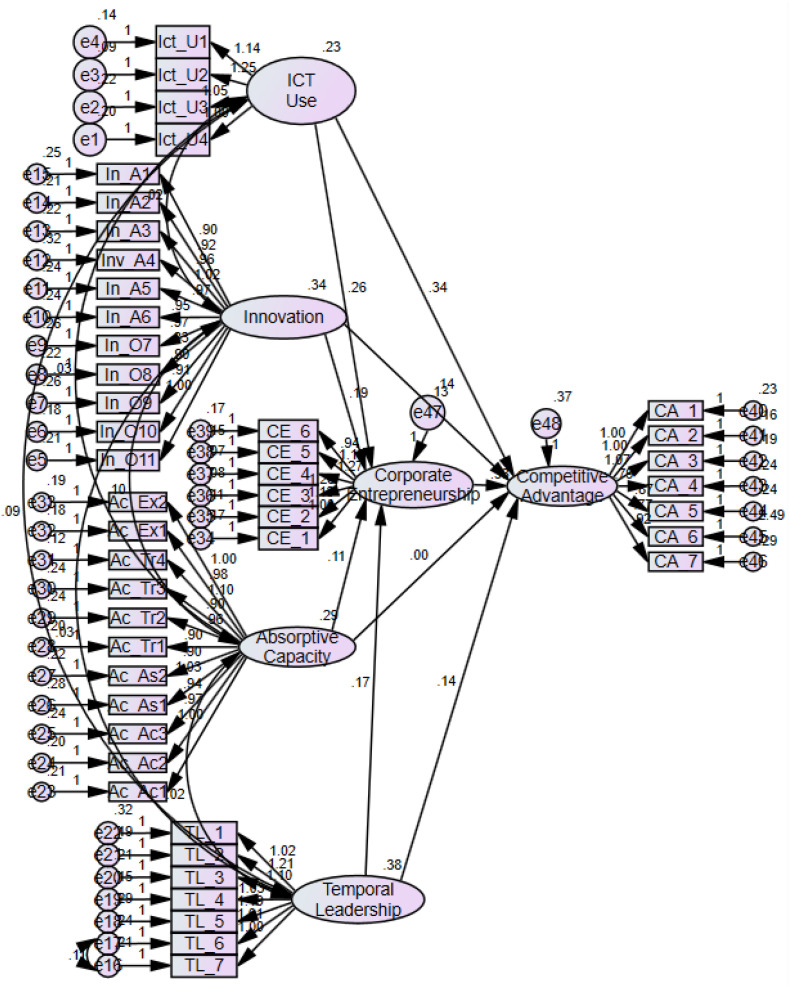
Regression estimates structural models.